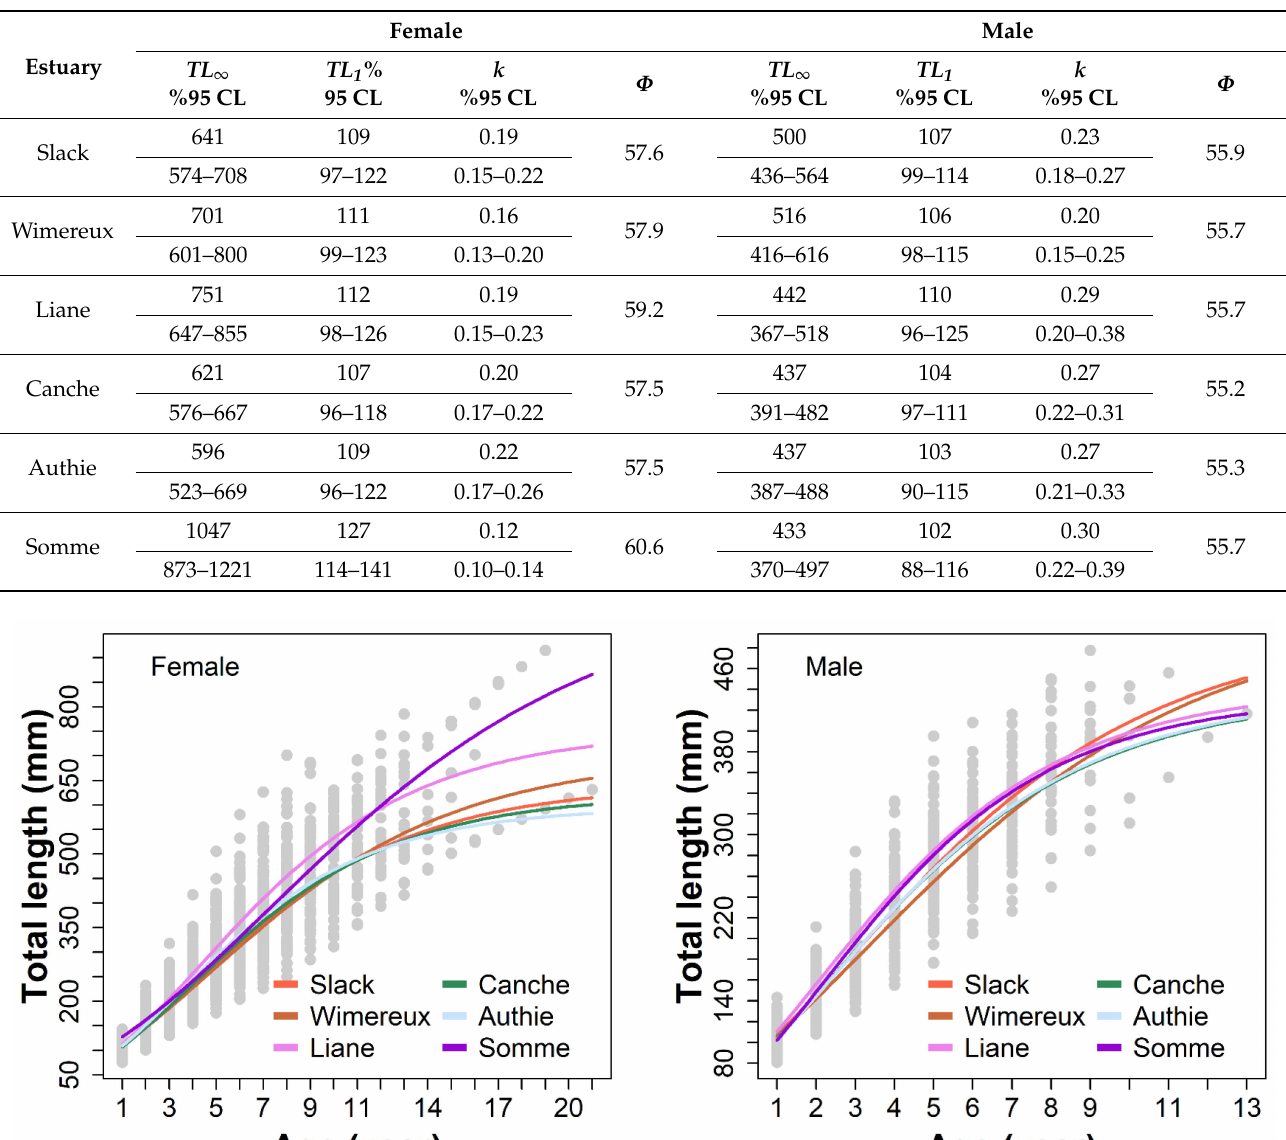
Table 2. Parameters of the Gompertz growth model and 95% confidence limits (%95 CL) for female and male eels collected in the six estuaries with TL ∞ the asymptotic length, TL 1 the length in the first year, k the rate at which the asymptote is reached, and Φ the growth performance index (mm · yr − 1 ).